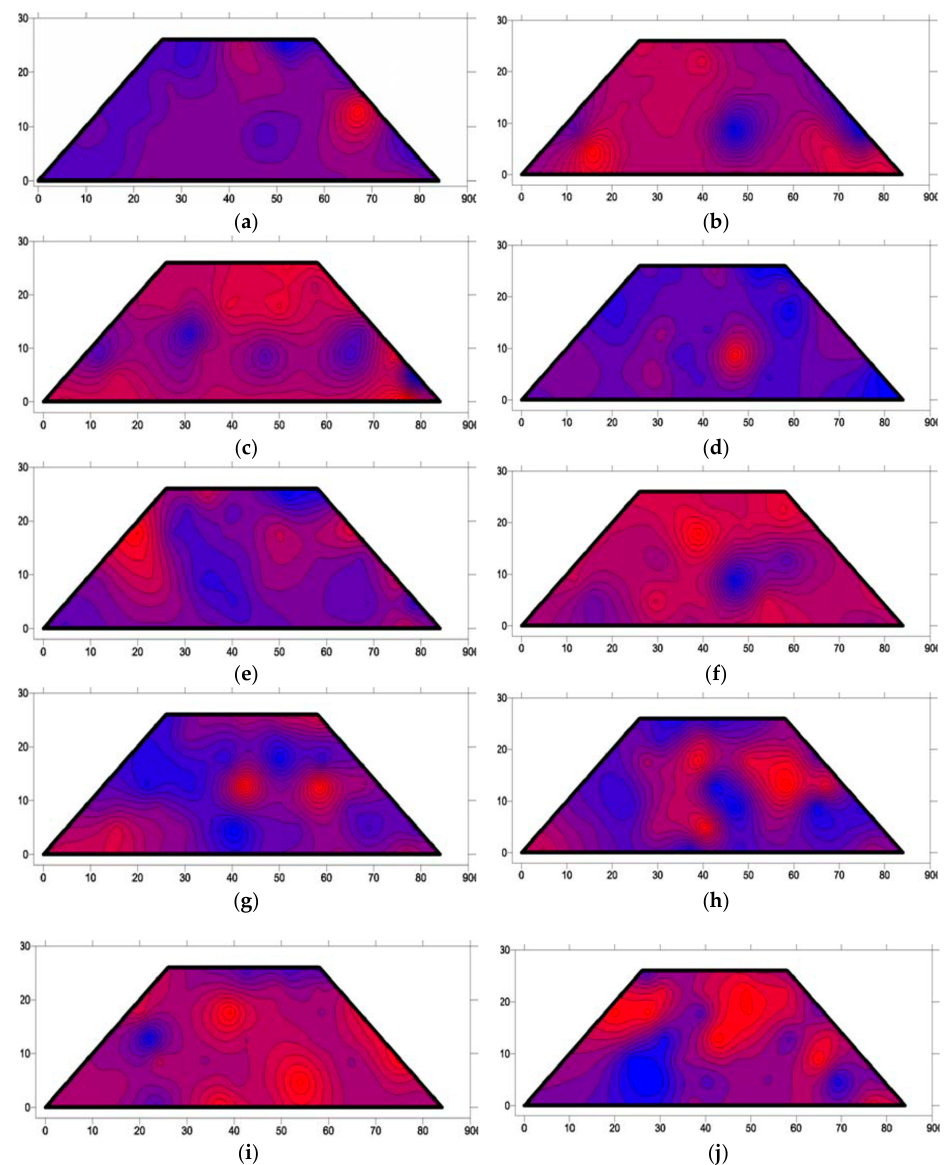
Figure 9. Results of modal analysis on the thar . Frequencies are ( a ) 269 Hz, ( b ) 387 Hz, ( c ) 516 Hz, ( d